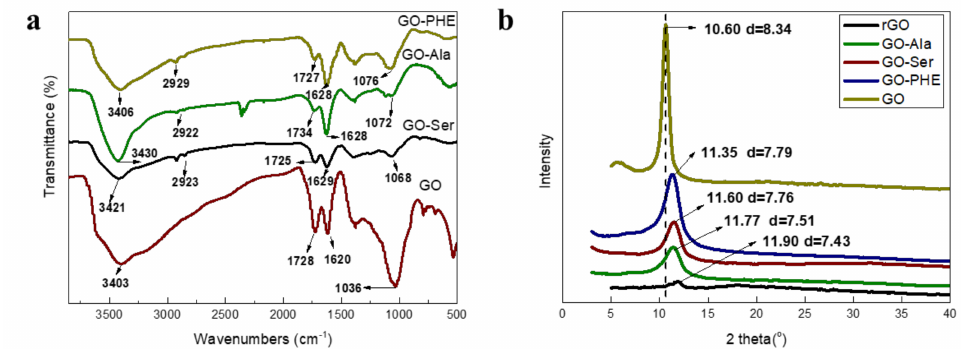
Figure 2. ( a ) FT-IR spectra of GO, GO-Ala, GO-Ser, GO-PHE, and ( b ) X-ray di ff raction (XRD) spectra of GO, rGO, GO-Ala, GO-PHE,